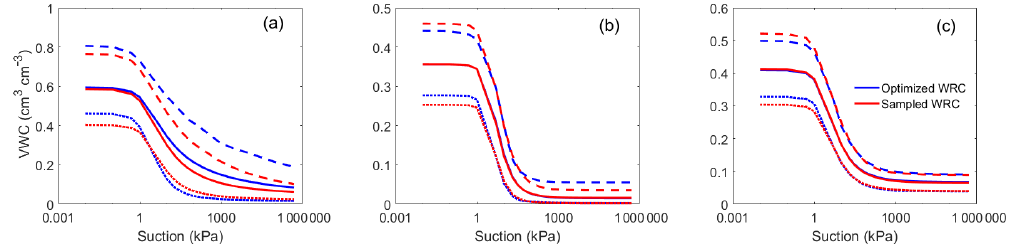
Figure 7. Estimated mean (solid lines) with 10th (dotted lines) and 90th (dashed lines) percentiles of the soil water retention curves (WRCs) for (a) peat, (b) subsoil, and (c) LOS obtained from the 155 optimized and 700 randomly sampled parameter values, where VWC denotes volumetric water content.